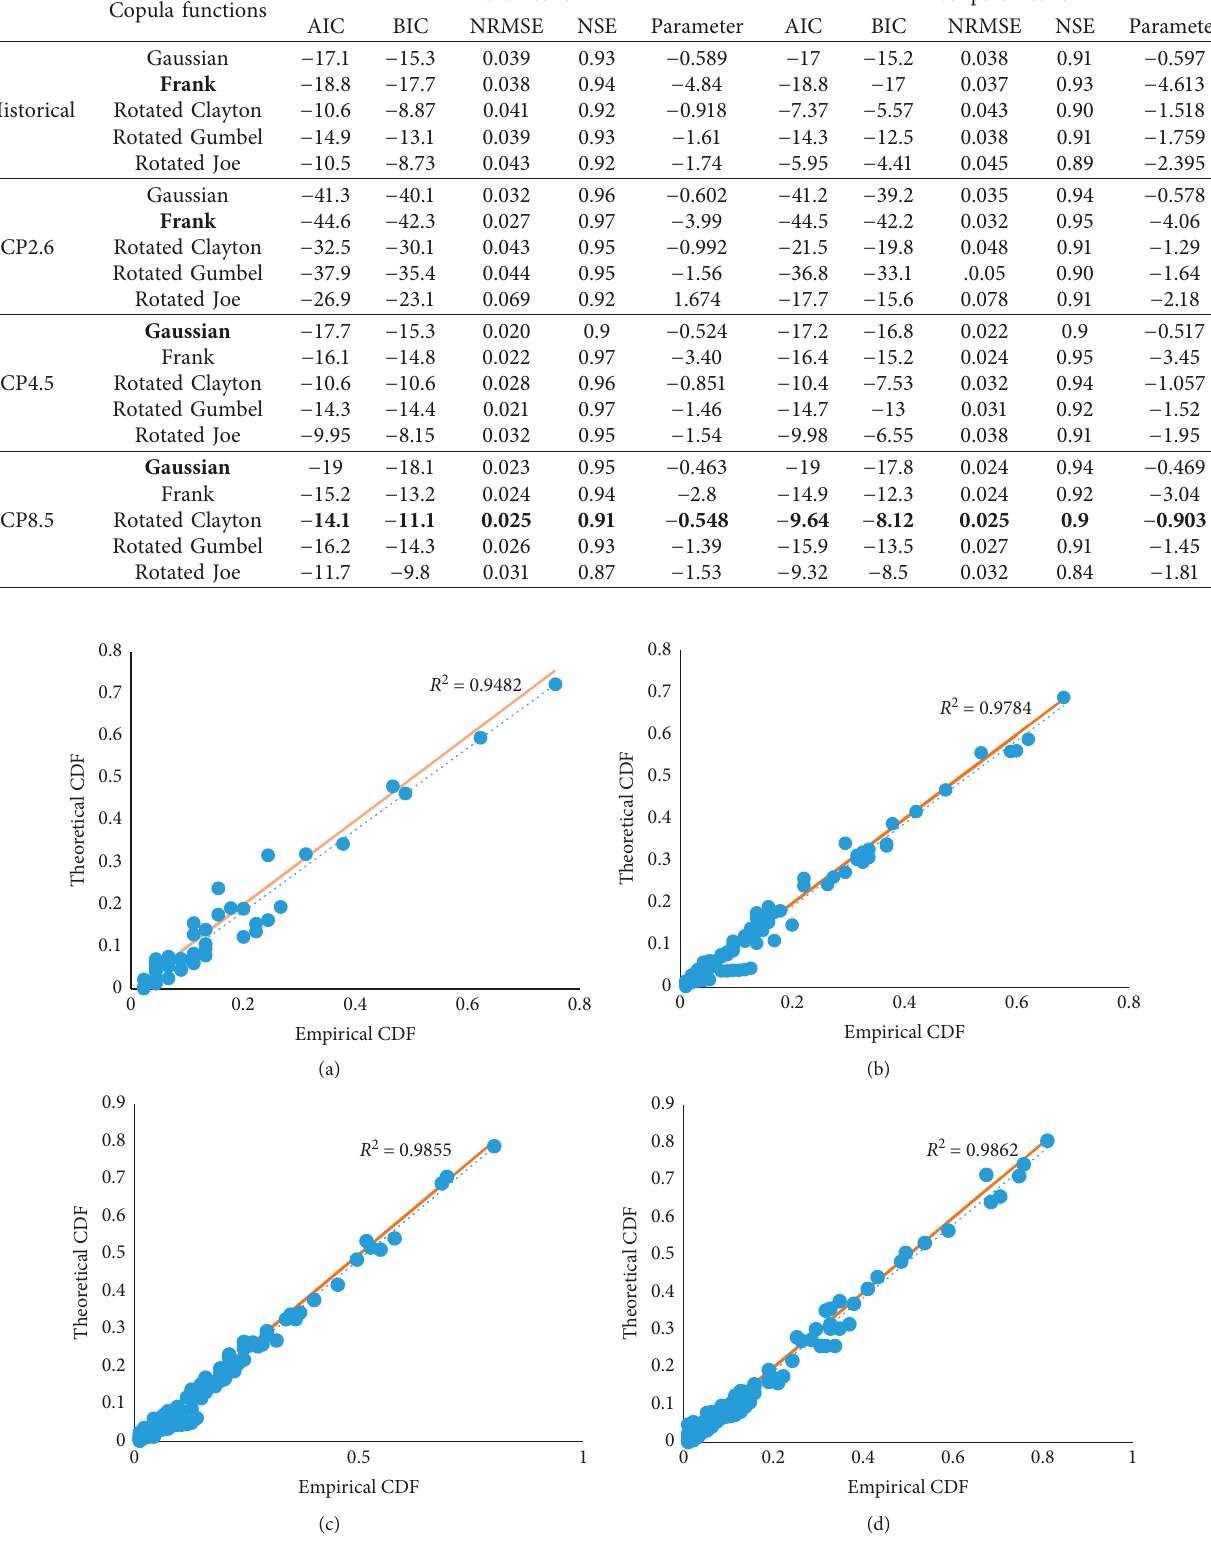
Figure 5: Q-Q plot for (a) historical data, (b) modeled data under RCP2.6, (c) modeled data under RCP4.5, and (d) modeled data under